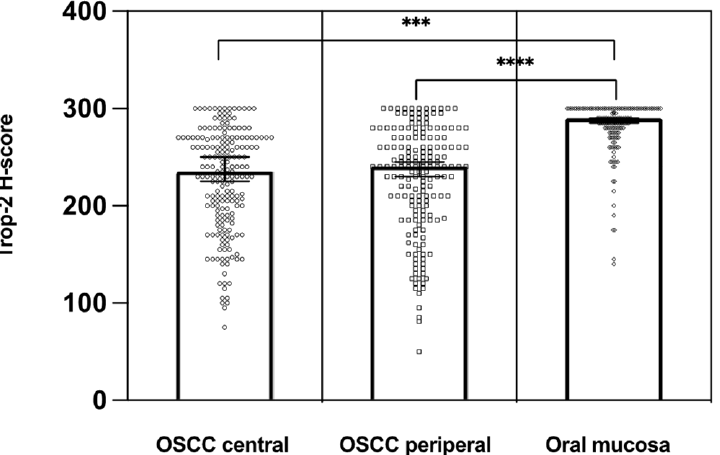
Figure 2. Distribution of Trop-2 H-scores in the central and peripheral tumor regions of OSCC compared to the corresponding non-neoplastic epithelial cells of the oral mucosa. Trop-2 expression was significantly higher in the normal oral mucosa than on cancer cells ( n = 160). *** p < 0.01, **** p < 0.001.